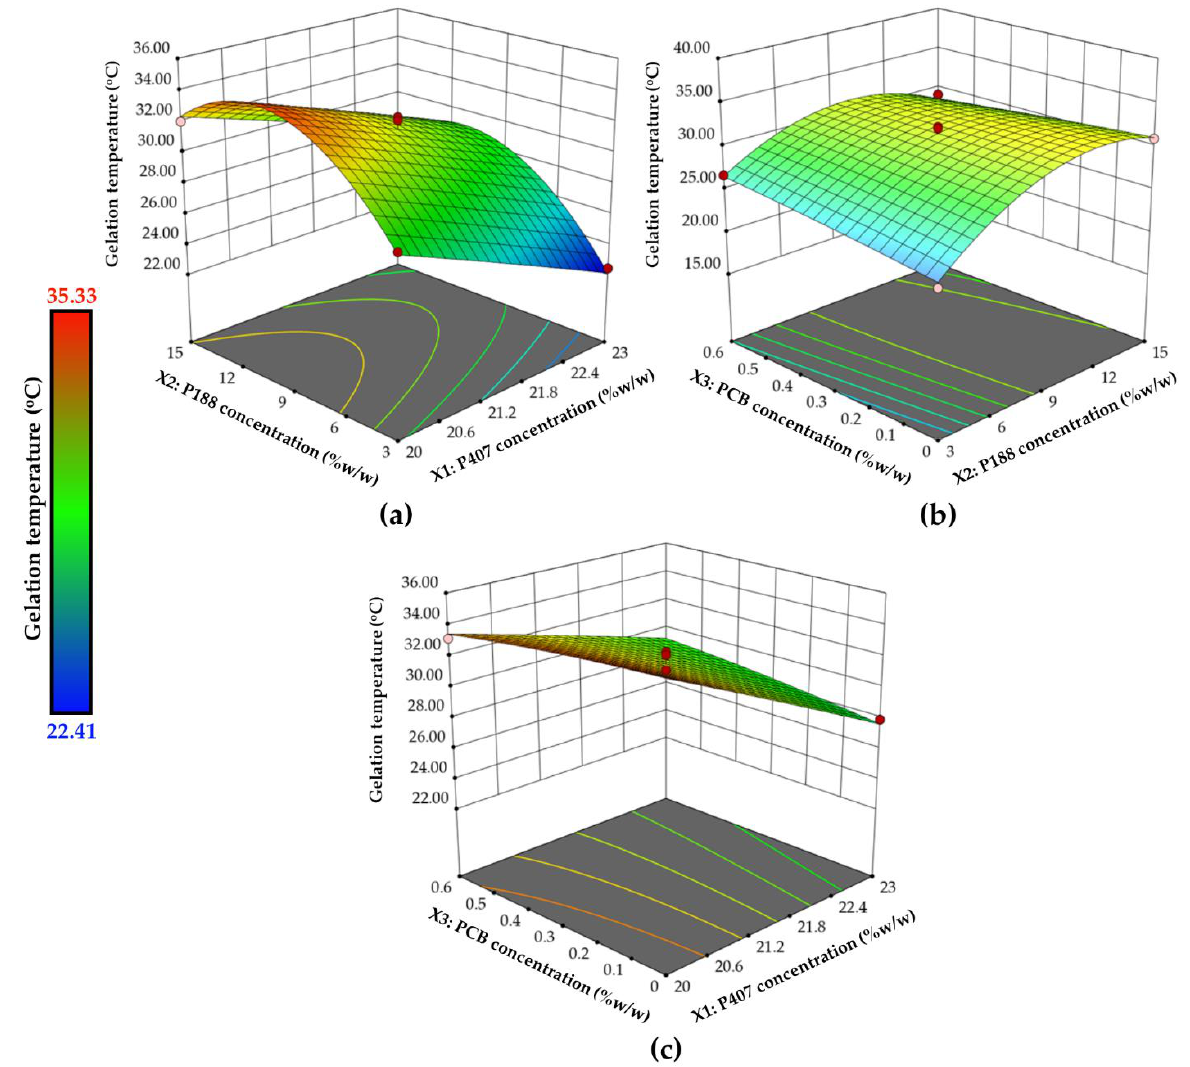
Figure 2. The 3D-response surface plots show the impact of different independent variables on the gelation temperatures; ( a ) effect of X 1 and X 2 at the mid-level of X 3 , ( b ) effect of X 2 and X 3 at the mid-level of X 1 , and ( c ) effect of X 1 and X 3 at the mid-level of X 2 .